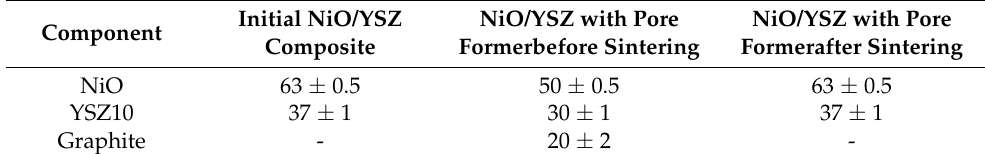
Table 3. Phase ratios of ceramic components (wt.%) calculated from X-ray diffraction patterns.